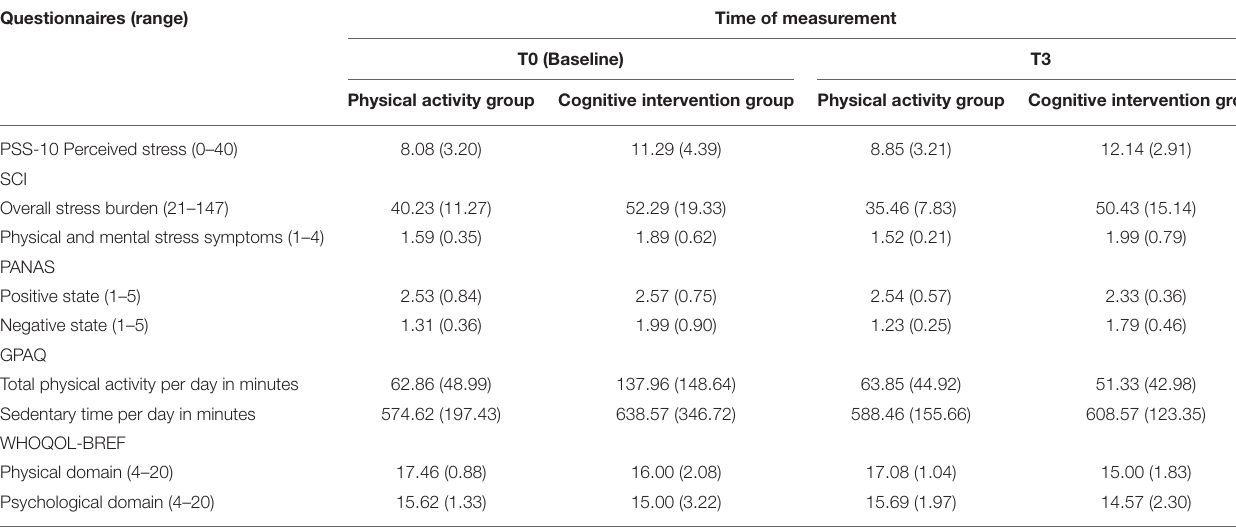
TABLE 2 | Mean scores and standard deviations (SDs in brackets) of scales in dependence of time of measurement (online questionnaire: physical activity group with n = 13, cognitive intervention group with n = 7). Questionnaires